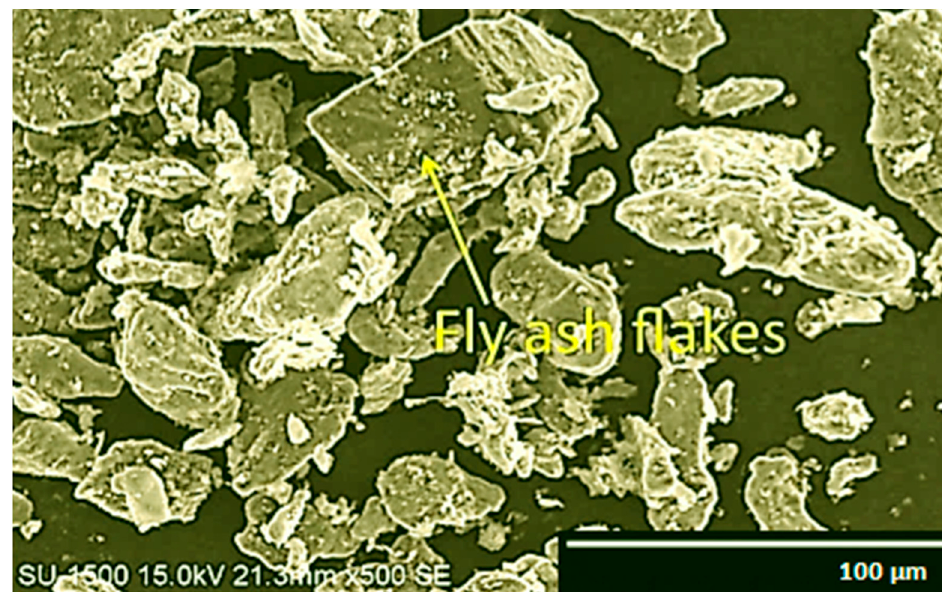
Figure 1. SEM of fly ash flakes at 500× magnification.